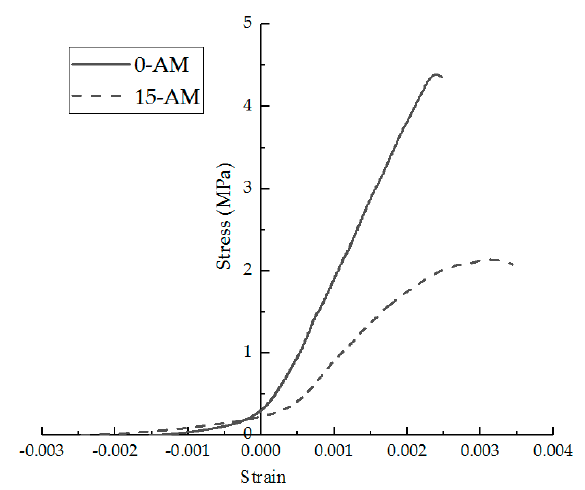
Figure 3. Stress–strain curve under freeze–thaw (F–T) cycles.